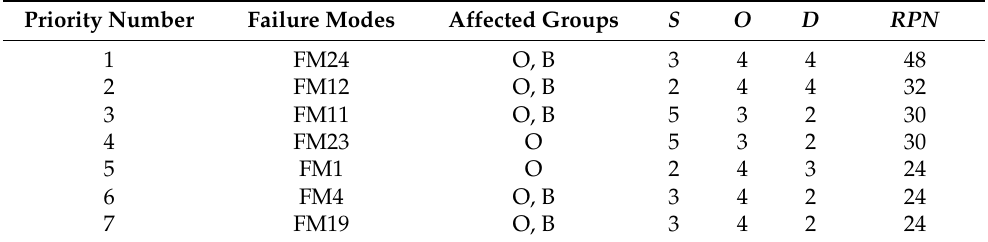
Table 5. Ratings for highest threat failure